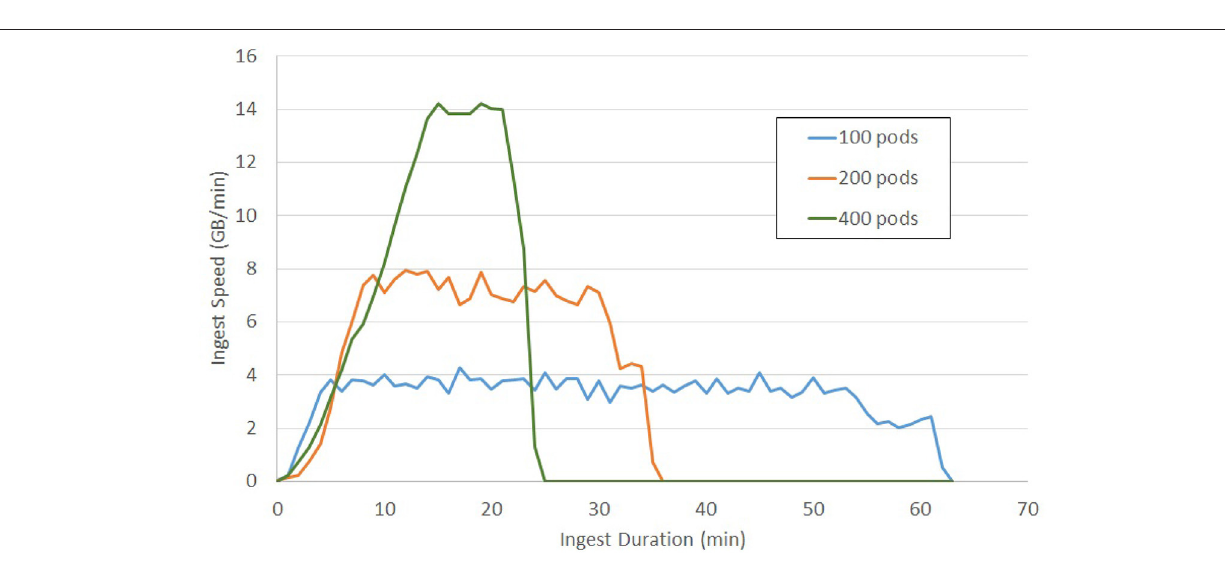
FIGURE 10 | Tile Ingest throughput on demand of a 200 GB EM dataset using various scales of ingest